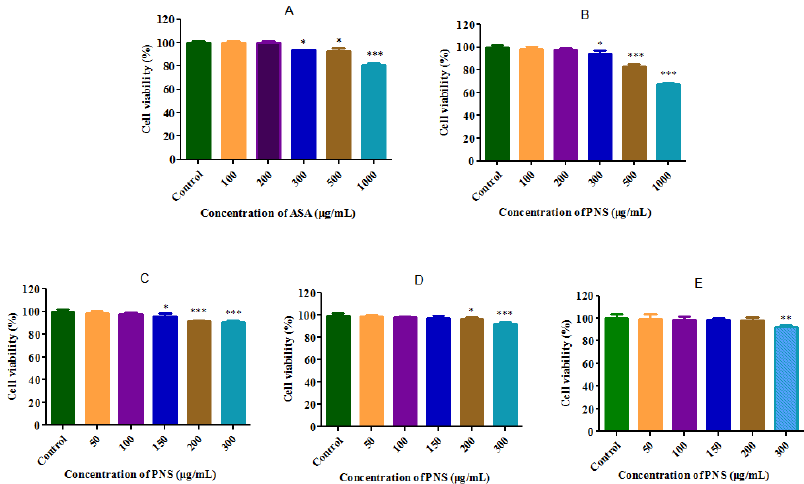
Figure 2. Cytotoxicity tests of aspirin (ASA), Panax notoginseng saponins (PNS) and their combinations as performed by MTT assay in Caco-2 cells. ASA and PNS had no cell cytotoxity under the concentration of 200 μg/mL, which was shown in ( A ) and ( B ). AP groups (PNS: ASA, 1:1, 3:2, 3:1, w / w ) had no cell cytotoxity under the concentrations of 100 µ g/mL, 150 µ g/mL and 200 µ g/mL in order, calculated by PNS, as shown in ( C ), ( D ), ( E ), respectively. Data were presented as mean ± SD ( n = 5). *, ** and *** denoted results significantly different from those of the control group ( p < 0.05, p < 0.01, and p < 0.001,